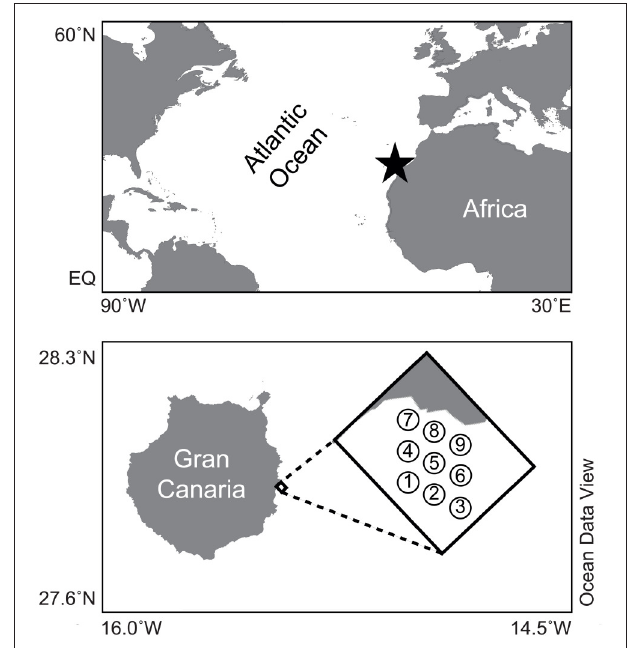
FIGURE 1 | Map of study site in the Atlantic Ocean. Mesocosms were moored in the Bay of Gando, off the coast of Gran Canaria (Spain).